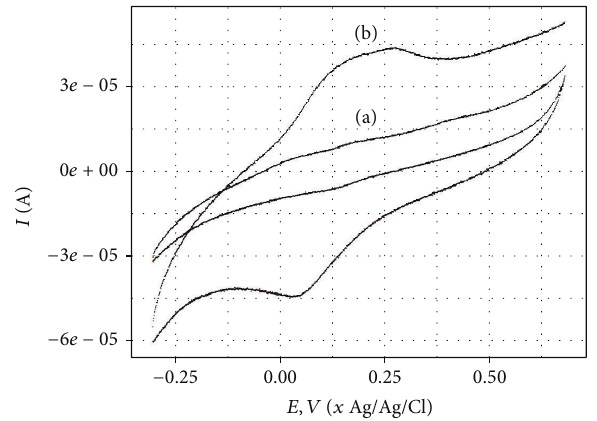
Figure 1: Cyclic voltammograms of Au electrode modified with PMMA- b -PDMAEMA (a) and Mb/PMMA- b -PDMAEMA (b) in 0.1mol ⋅ L −1 sodium phosphate buffer solution (pH 7.45). Scan rate: 100mV/s.